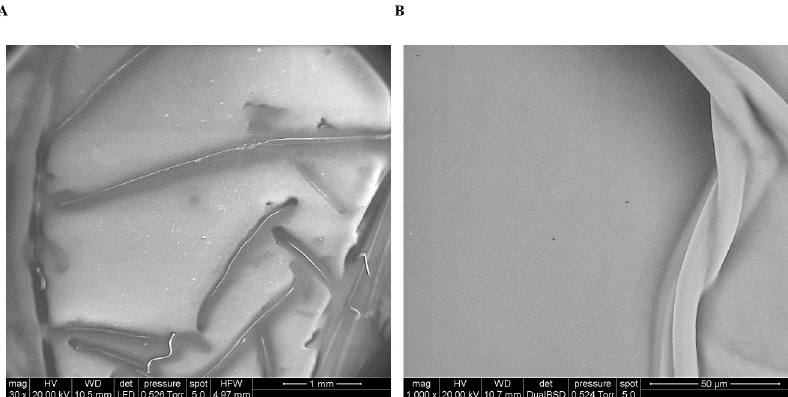
Fig 3. SEM analysis of decellularized Descemet’s membrane’s surface morphology. SEM images of dDM showing a dense membrane with several folds interspersed along the surface: ( A ) X 30, ( B ) X 1000.